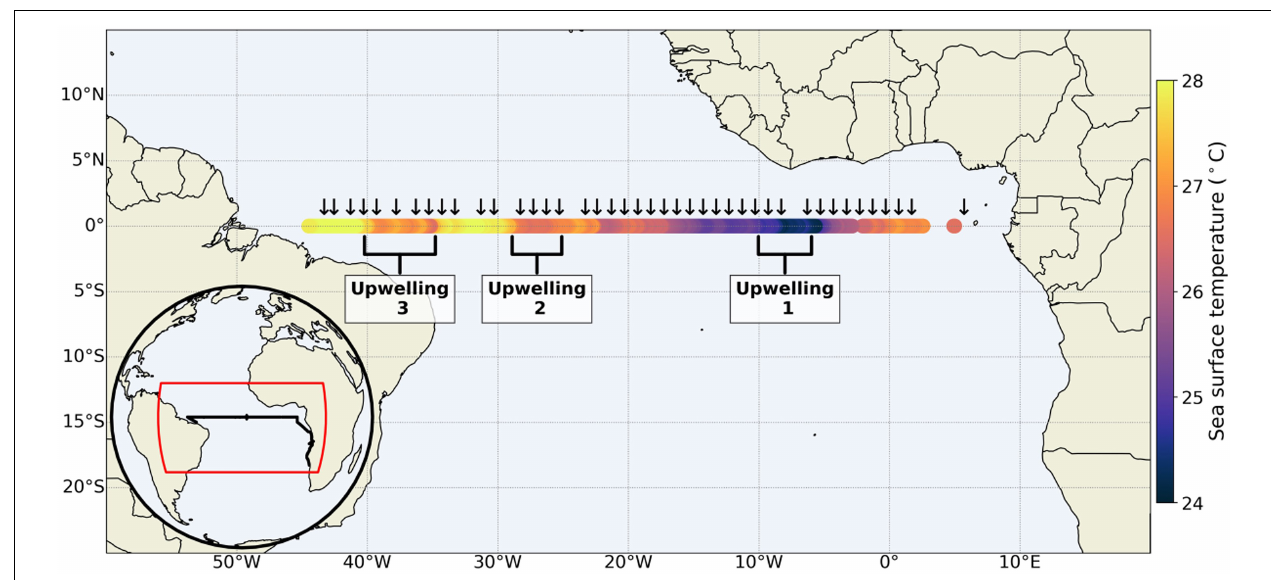
FIGURE 1 | Black arrows denote stations along the Equator which included CTD casts with concurrent collection of samples for nutrient and FIRe analysis (not all CTD casts are represented here). Insert at bottom left shows the full cruise track (black line). Three regions are marked as Upwelling 1, 2, and 3 that are associated with events of upward nutrient